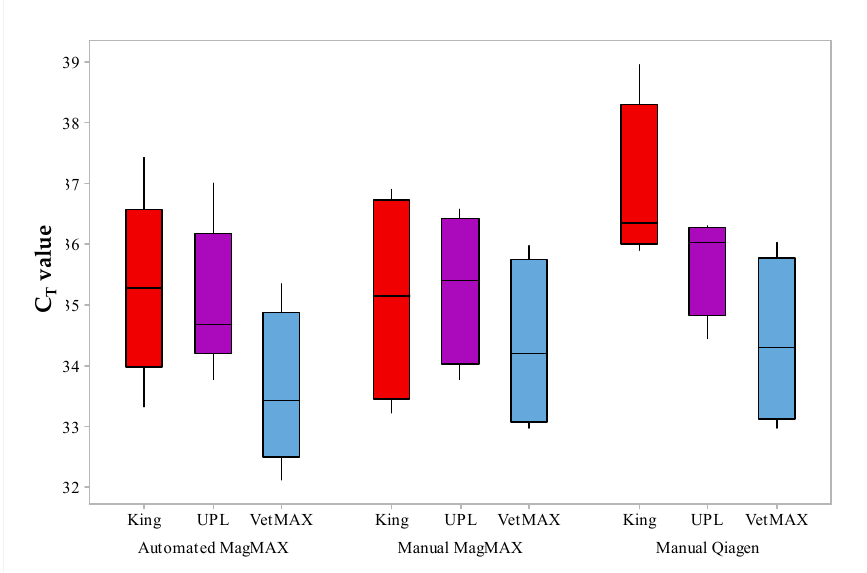
Figure 2. Boxplot of C T values obtained following automated or manual extraction systems. The median C T value and the interquartile range for each assay following each extraction system is shown.